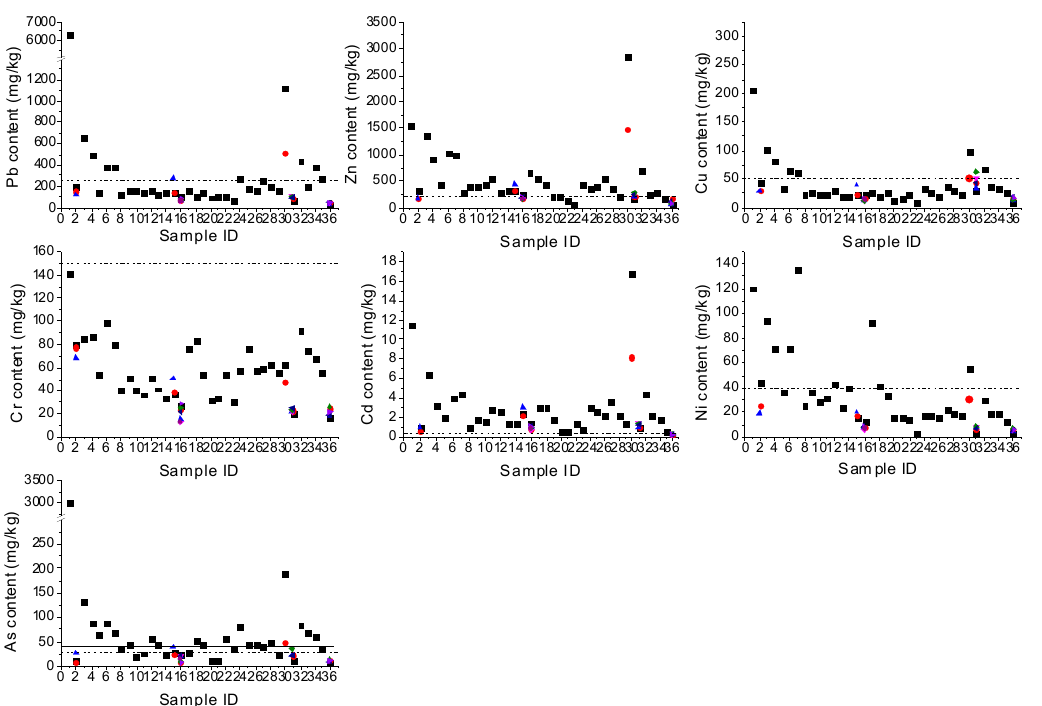
Figure 3. Heavy metal concentrations in all soil samples. Notes: Sample ID 1–36 were compiled with increasing distance from the tailing pond, and sample from ID 1 stand for the tailing sample; since some various vegetable soils were collected in a smallish area, the sample ID of these vegetable soils sampled from a smallish area are represented by the same sample ID, we use different colors to represent these vegetable soils; reference lines (dash) are Grad II values of Environmental Quality Standards for Soils in China (GB15618-1995), while reference line (solid) for As is the standard value of paddy soil.